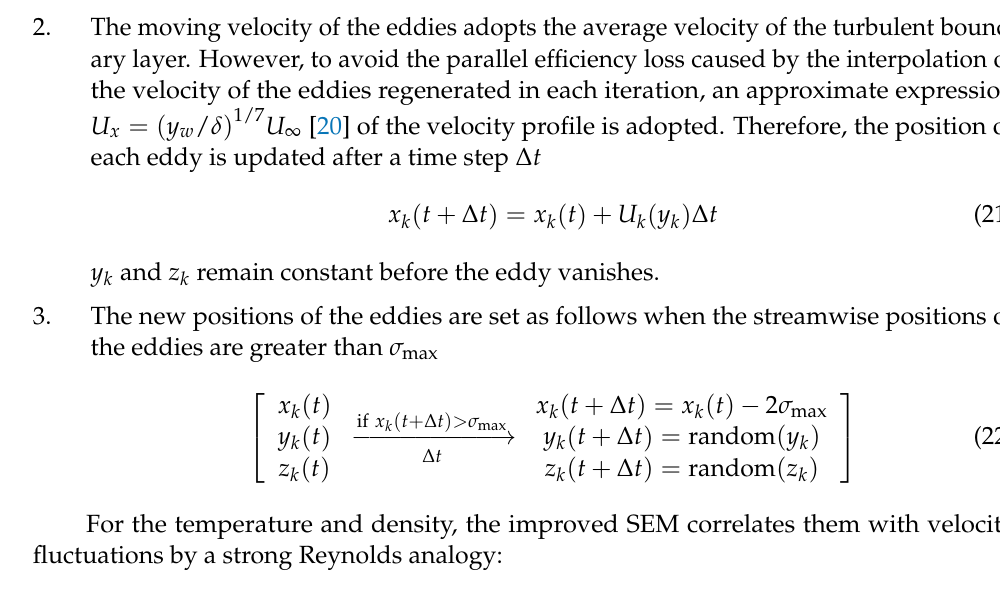
Figure 4. Profiles of integral turbulence length scale and eddy radii.